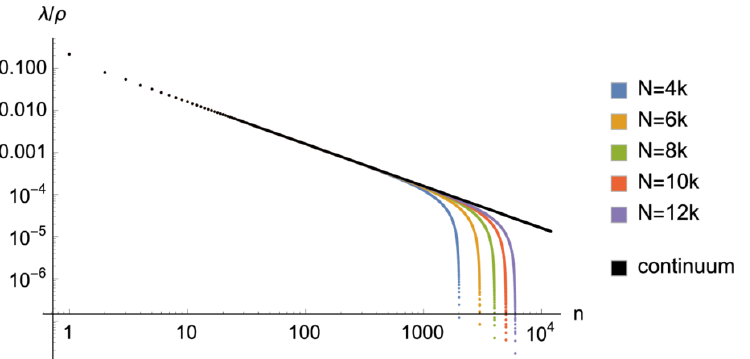
Figure 2. Log-log plot of the eigenvalues of i ∆ divided by density ρ (except for the continuum), in the 2d causal diamond; m = 0.